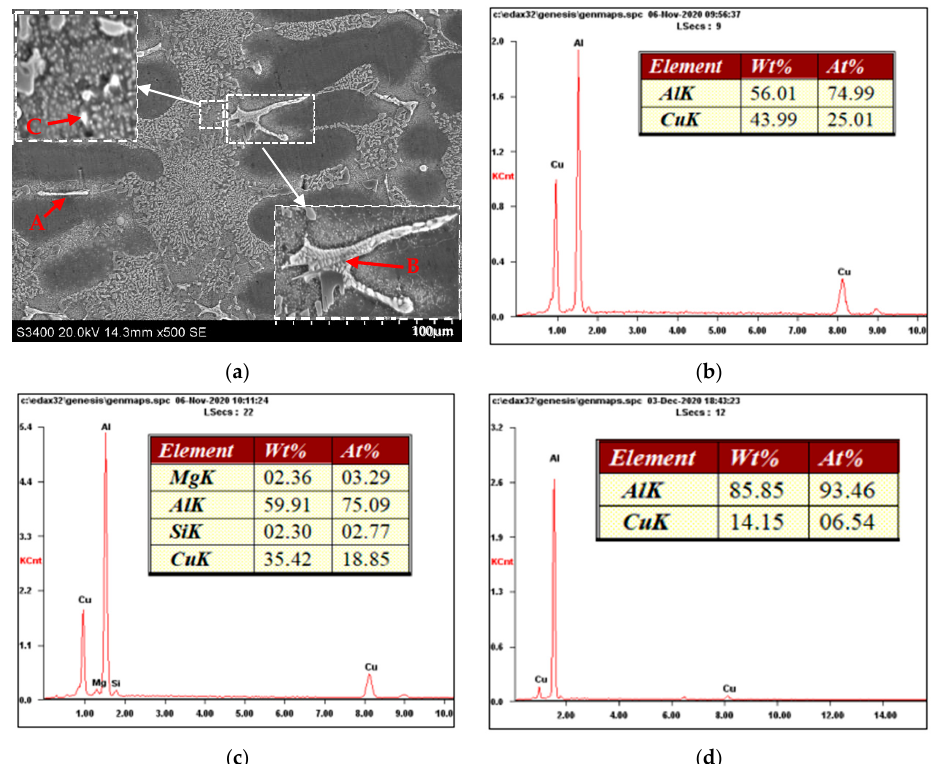
Figure 5. Microstructure of Al-10Si-3Cu-0.3Mg alloy and EDS energy spectrum analysis of its corresponding phases: ( a ) SEM microstructure of Al-10Si-3Cu-0.3Mg; ( b ) EDS spectrum corresponding to A in ( a ); ( c ) EDS spectrum corresponding to B in ( a ); ( d ) EDS spectrum corresponding to C in ( a ).